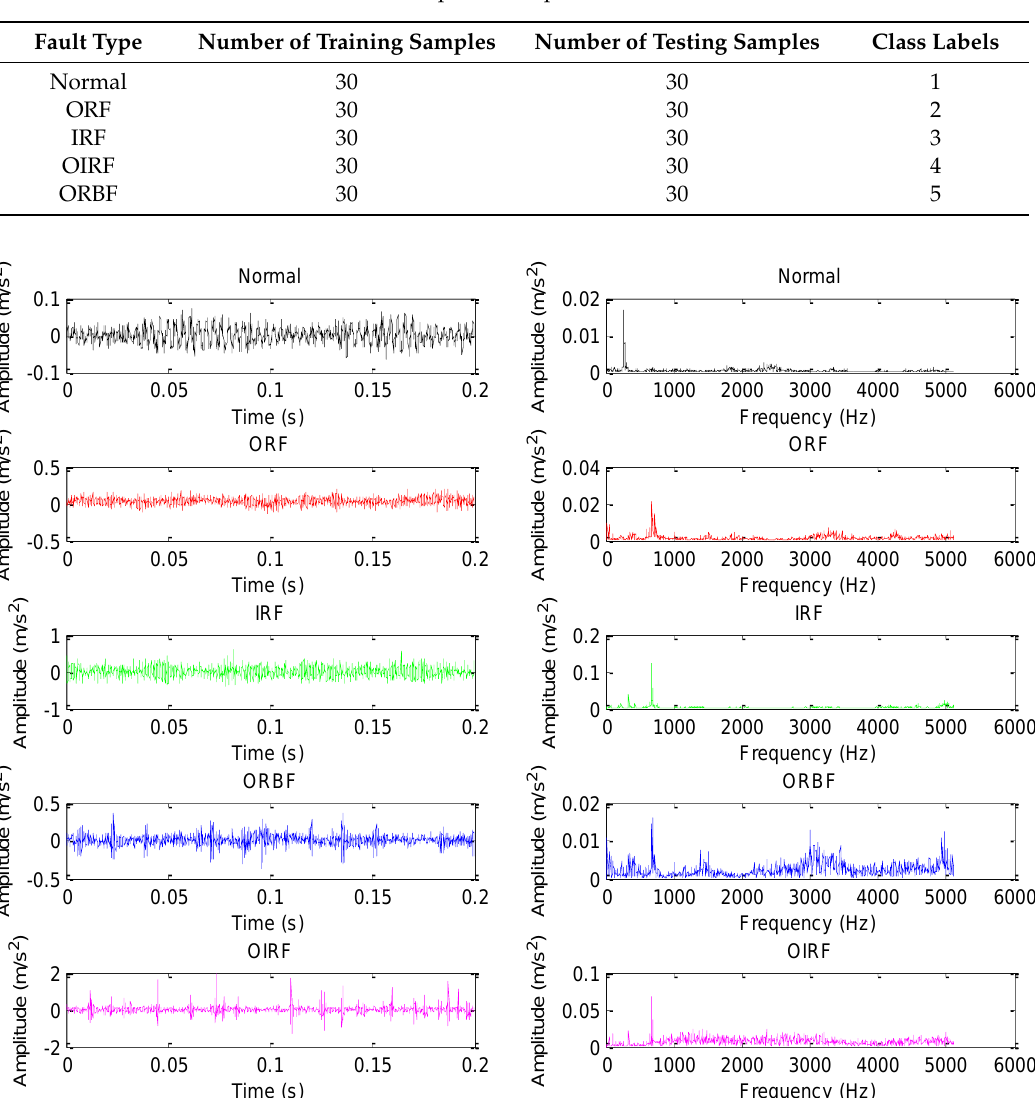
Table 3. Defect frequencies of rolling bearing (Hz). Table 4. Description of experimental dataset. Table 4. Description of experimental dataset.